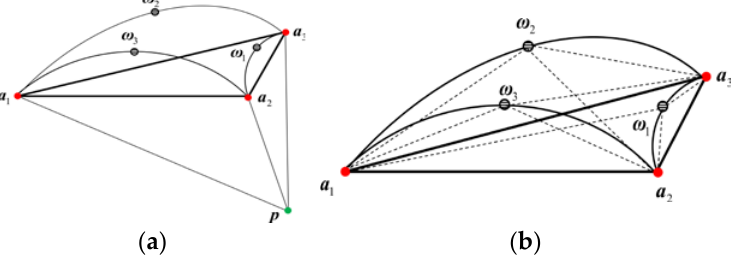
Figure 4. Illustration of projection in the feature subspace. ( a ) construction of the nonlinear vertex p ; ( b ) geometric distance measure-based projection using nonlinear planes.